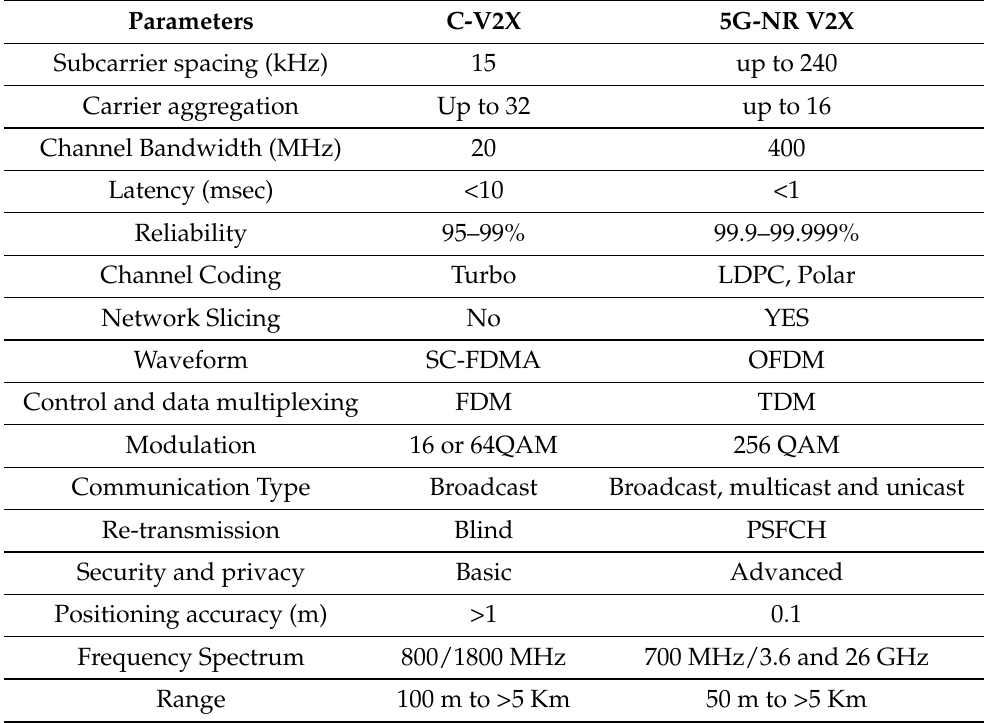
Table 7. Comparison of long-range